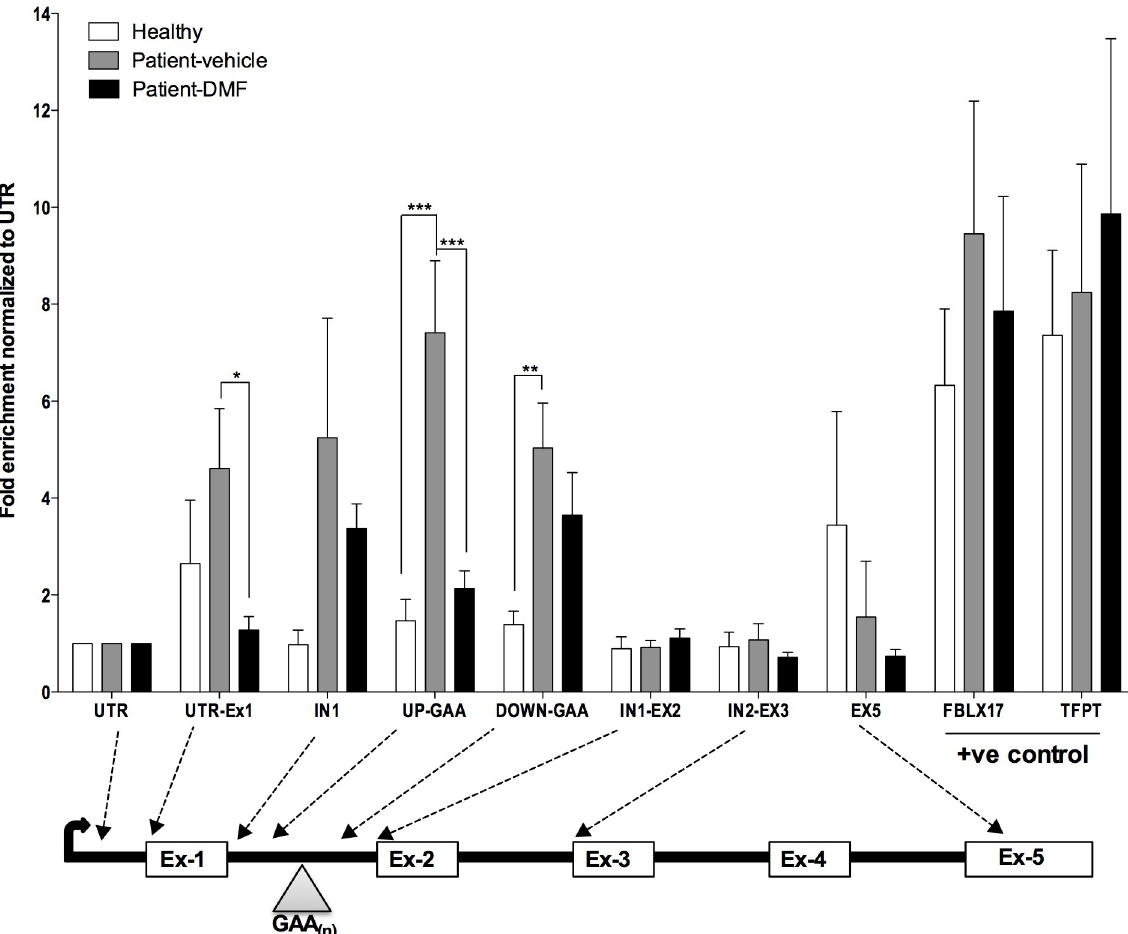
Fig 4. DMF reduces R-loop enrichment at GAA repeat pause site of FXN gene. R-loops were enriched using antibody specific for RNA-DNA hybrid and fold enrichment measured relative to input DNA by qPCR in healthy lymphoblast (GM-13068), patient derived lymphoblast (GM14518) and in patient lymphoblast cells (GM-14518) treated with 30uM DMF for 24 hr. Bars represent averages ± standard deviations (n = 6, each group, p < 0.05 � , p < 0.01 �� , p < 0.001 ��� ).